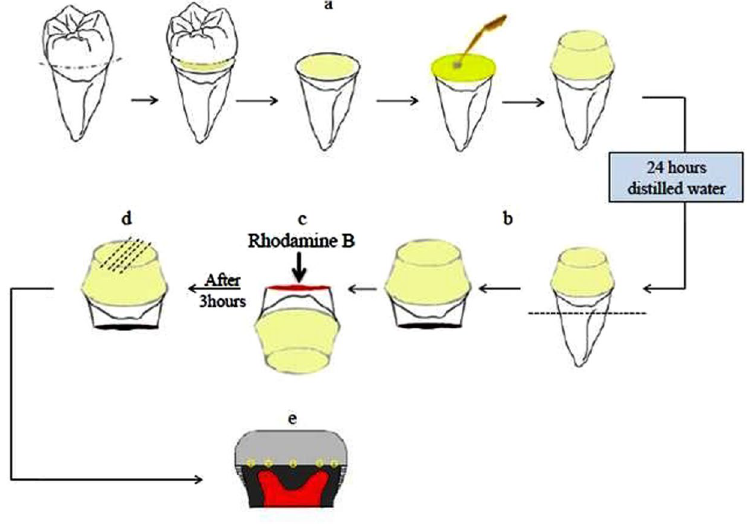
Figure 4. Procedure to record micro permeability.